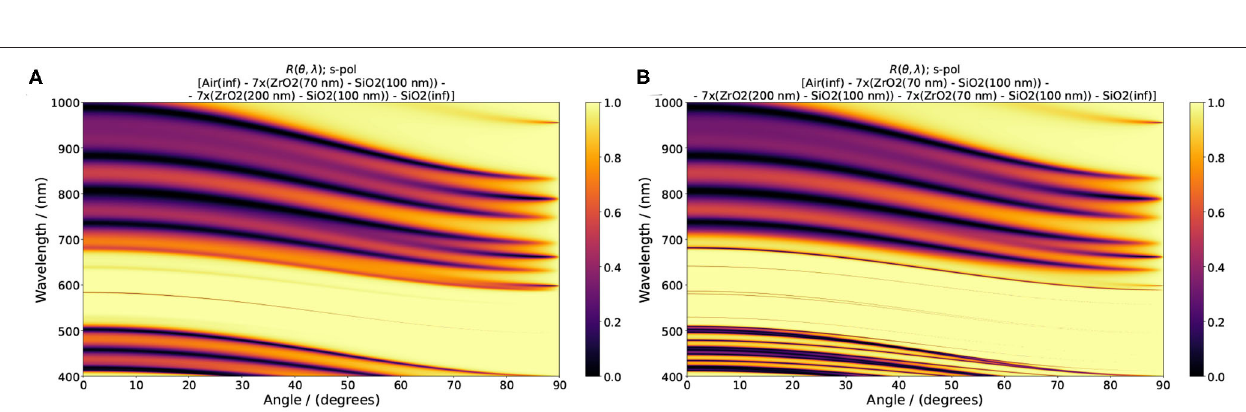
Frontiers in Nanotechnology |